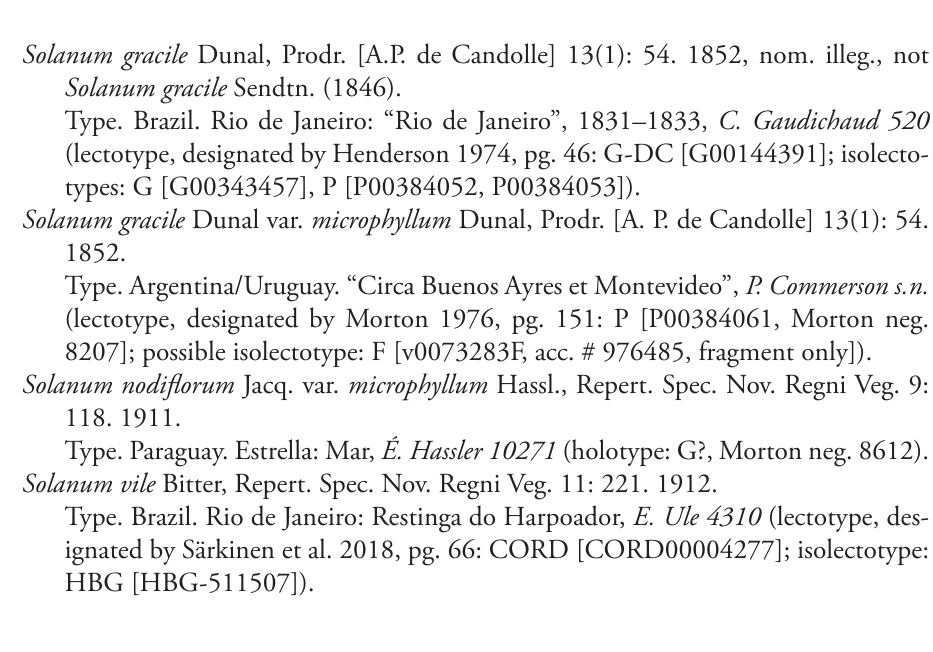
Figure 7. Solanum chenopodioides Lam. A Habit B buds C flowers at full anthesis D fully mature matte black fruits with appressed calyx lobes ( A–D Nijmegen accession A14750051). Photos by S. Knapp and G. van der Weerden (previously published in “PhytoKeys